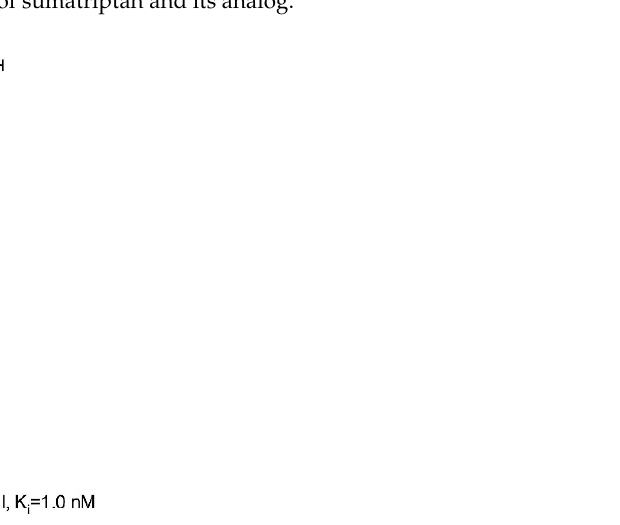
Figure 3. 5-HT 6 binding affinity of constrained N1-arylsulfonyltryptamine derivatives [14,15].